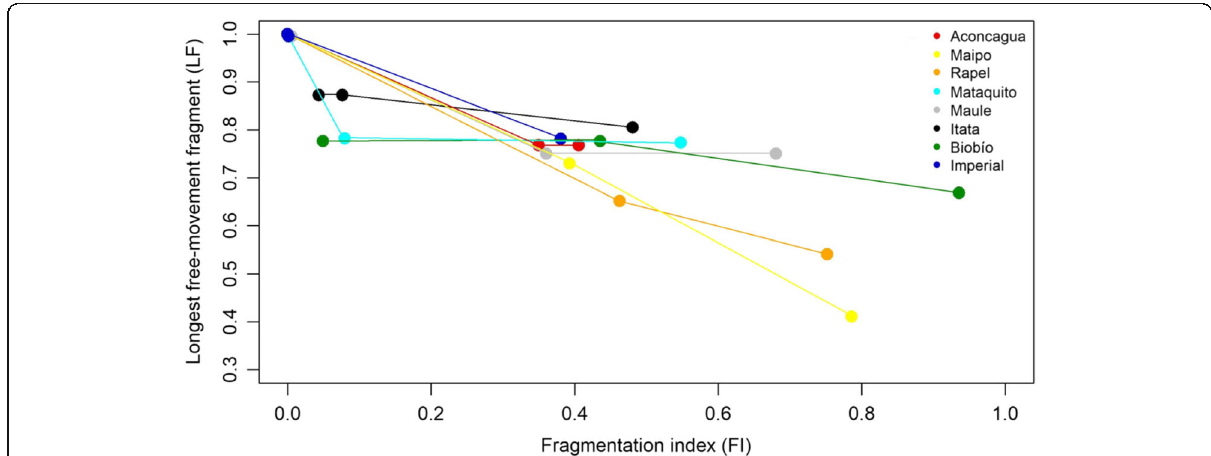
Fig. 7 Changes in fragmentation of analysed basins from the ‘ natural ’ to current (2018) and from current (2018) to future (2050)